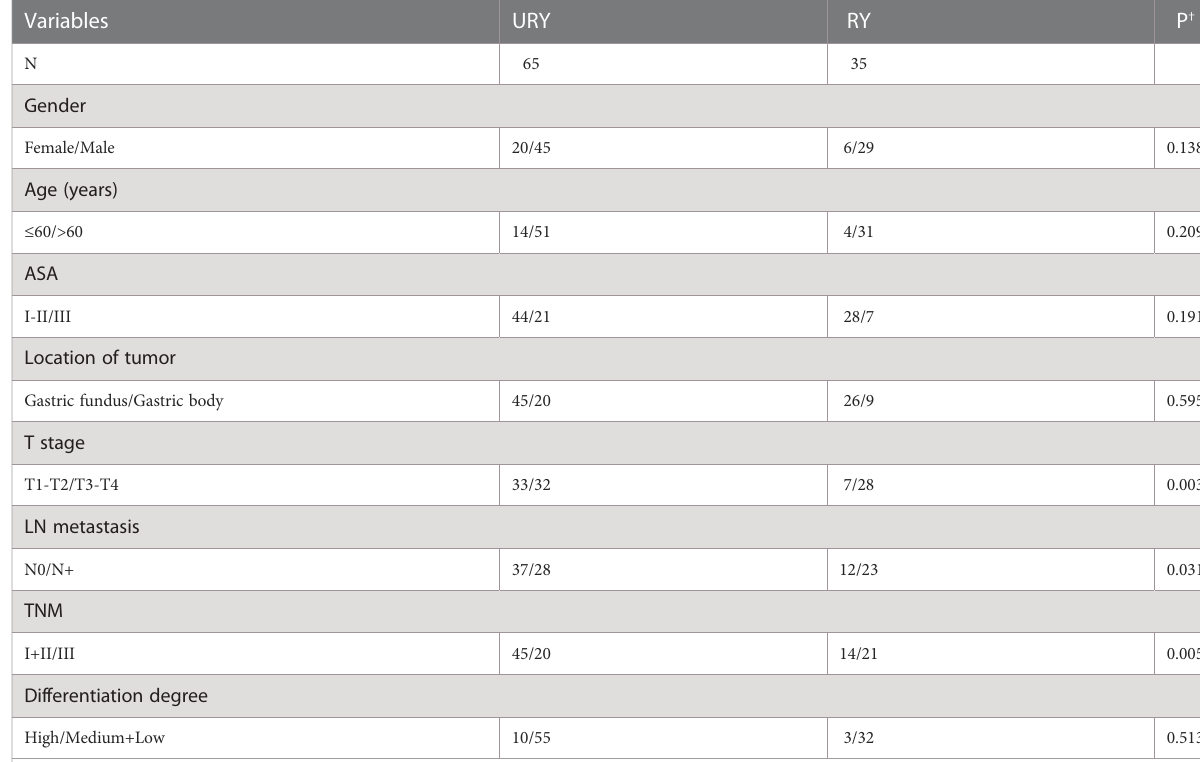
TABLE 1 Baseline characteristics of the including